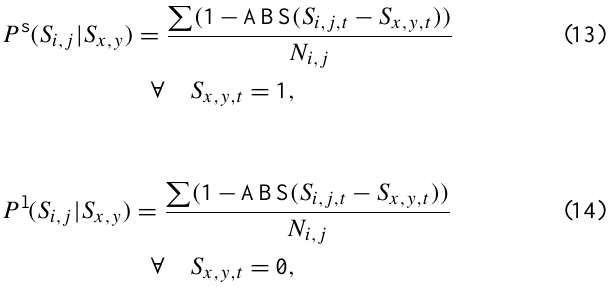
classified according to the station record. The idea